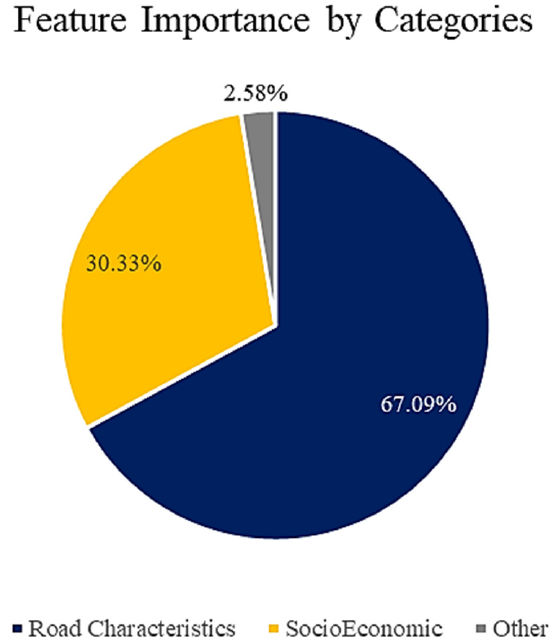
Figure 12. Feature importance categories for best-performing models for PVs using RF model (4th split).